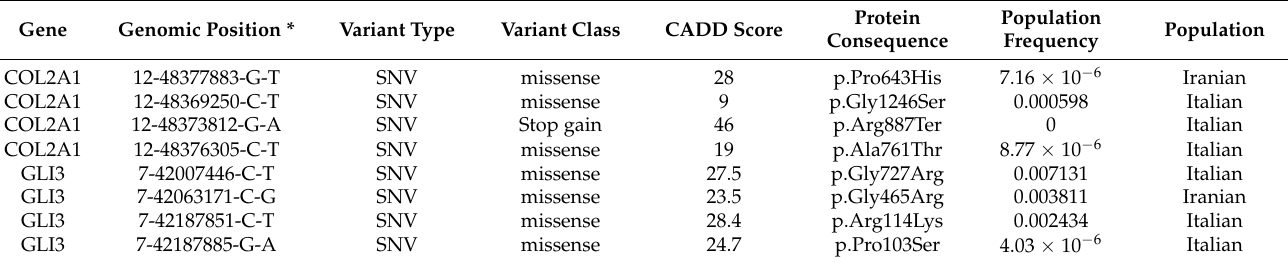
Table 3. Variants identified by GCA in COL2A1 and GLI3 are